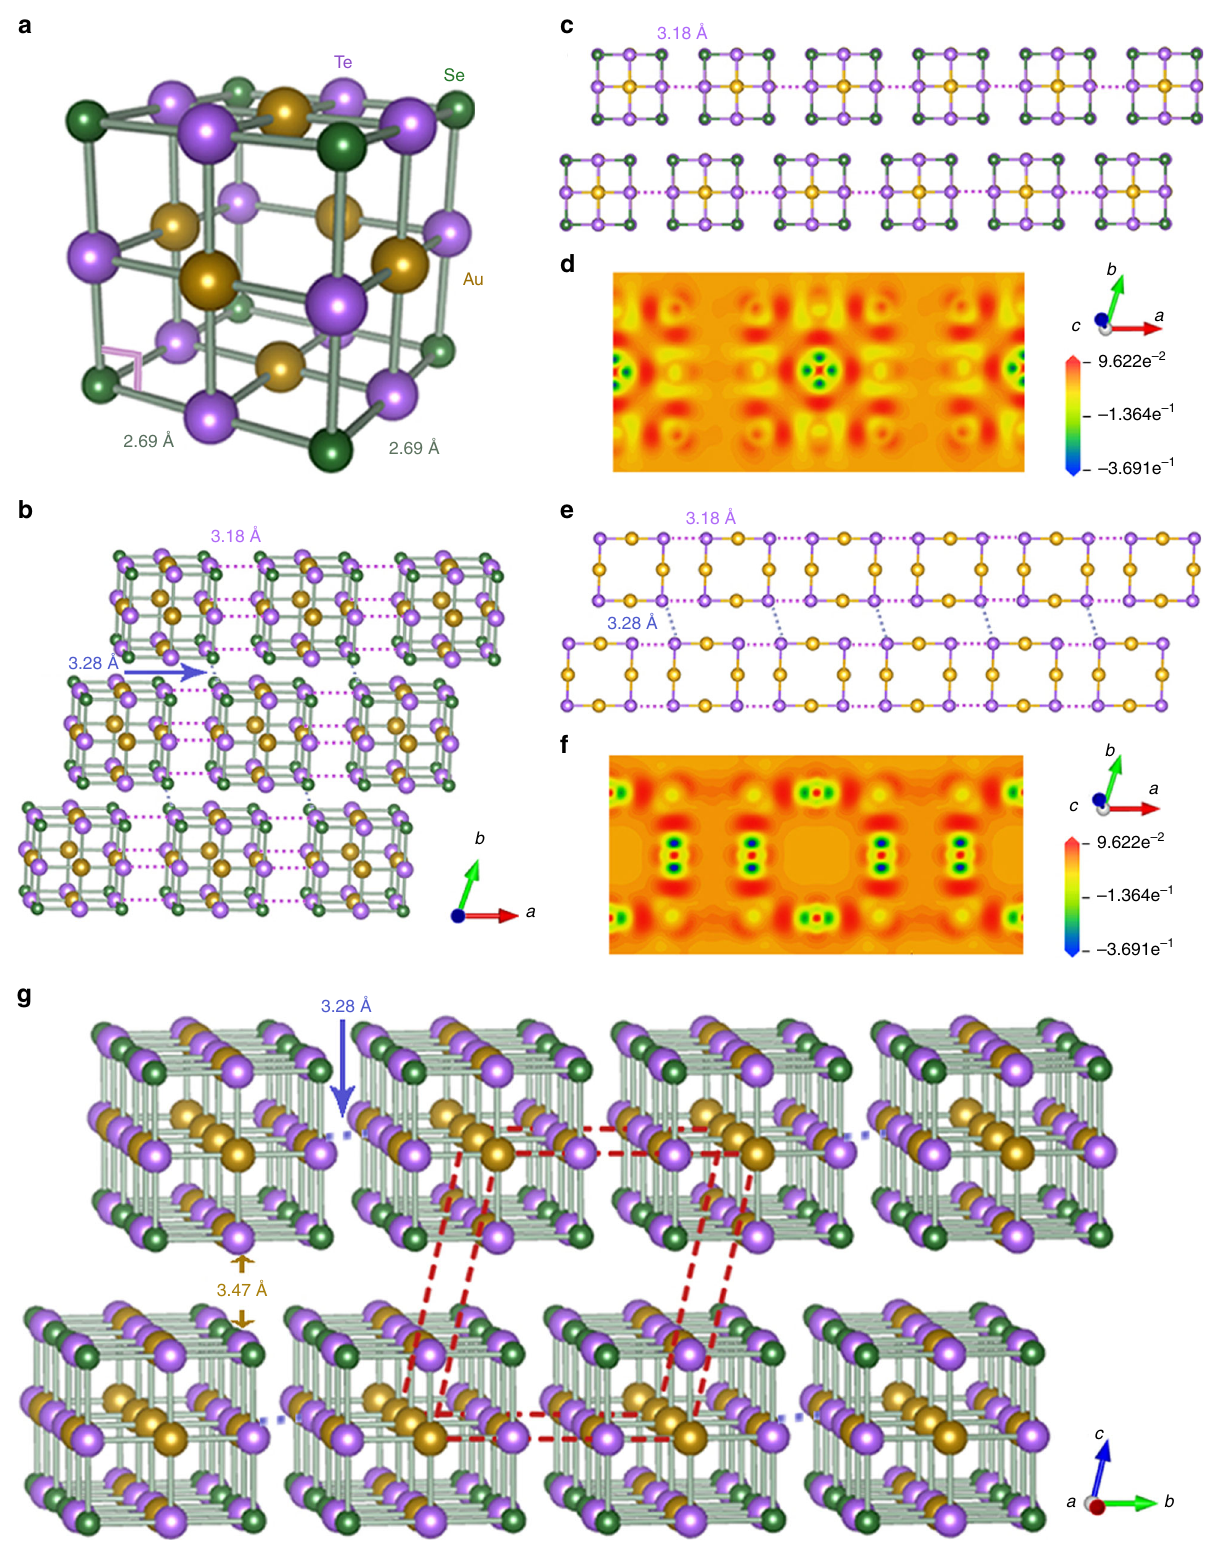
Fig. 2 Crystal structure and electron density difference of AuTe 2 Se 4/3 . a The structure of single block of atomically ordered Au – Te – Se. b The stereotype structure of the ab -plane with two kinds of Te – Te bond lengths of 3.18 and 3.28 Å. c The strips of front/back face of cubic arrays. The violet dash lines denote the Te – Te bonds of neighbor cubes along the a -axis. d The calculated EDD of front/back face, which is calculated by subtracting free atom electron density from the total electron density. The plus and minus scale represent the accumulated and depleted electrons. e The strips of middle layer of cubic arrays. The two violet and one blue dash lines denote the Te – Te bonds of neighbor cubes. f The corresponding EDD images of middle layer. g The whole crystal structure of AuTe 2 Se 4/3 . The dash lines represent the triclinic unit cell ( P −